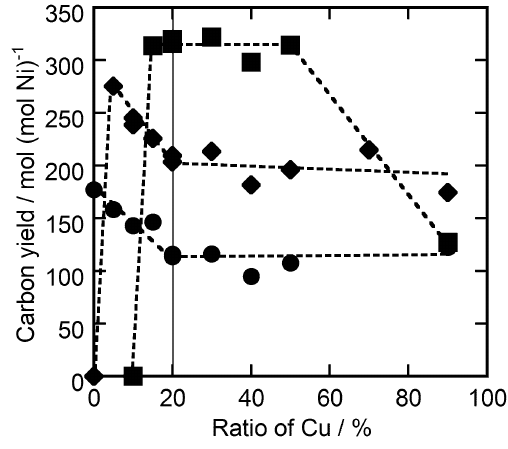
Fig. 3 The effect of Cu addition in the Ni-Cu bimetal catalyst on the carbon yield under various reaction temperatures of 550 °C (solid circle mark), 600 °C (solid rhombus mark), and 650 °C (solid square mark),